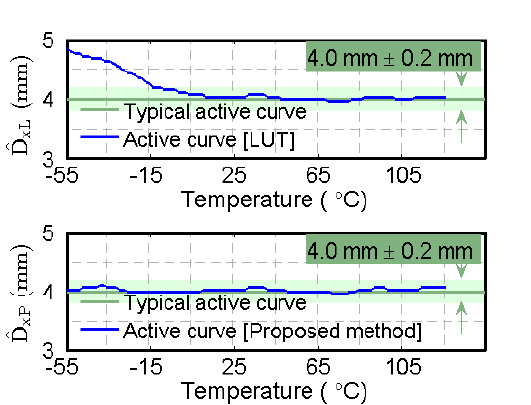
Figure 15. ˆD x and ˆD x of 4 mm (the red curve of ˆD x L P low temperature; by contrast, the blue curve of ˆD x